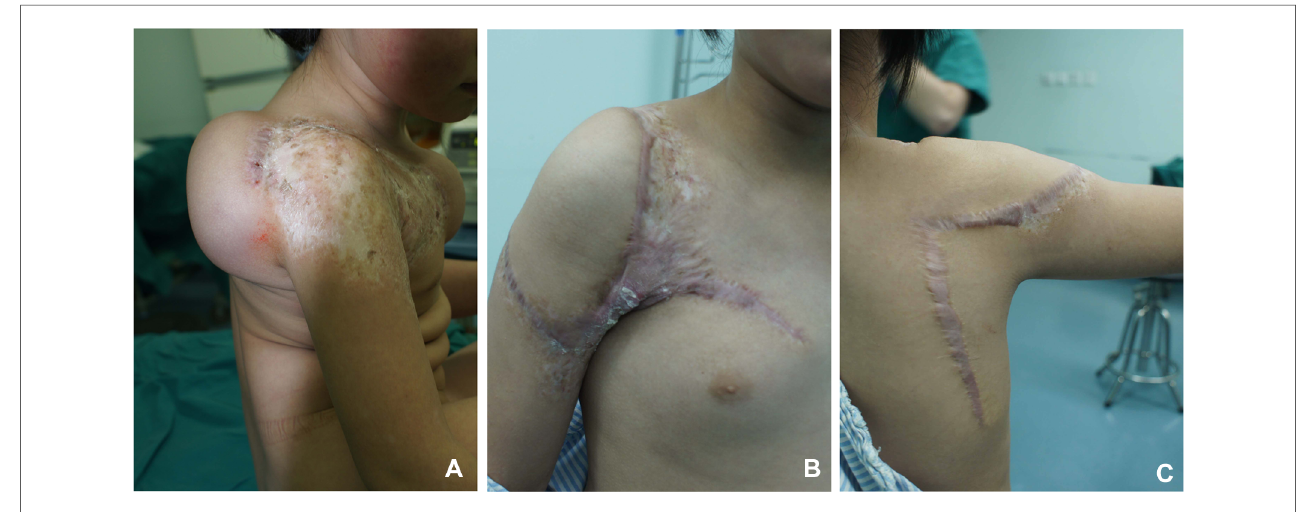
FIGURE 7 Case 2. ( A ) Preoperative appearance of the expanded fl ap. ( B ) Anterior view at postoperative follow-up. ( C ) Posterior view at postoperative follow-up.